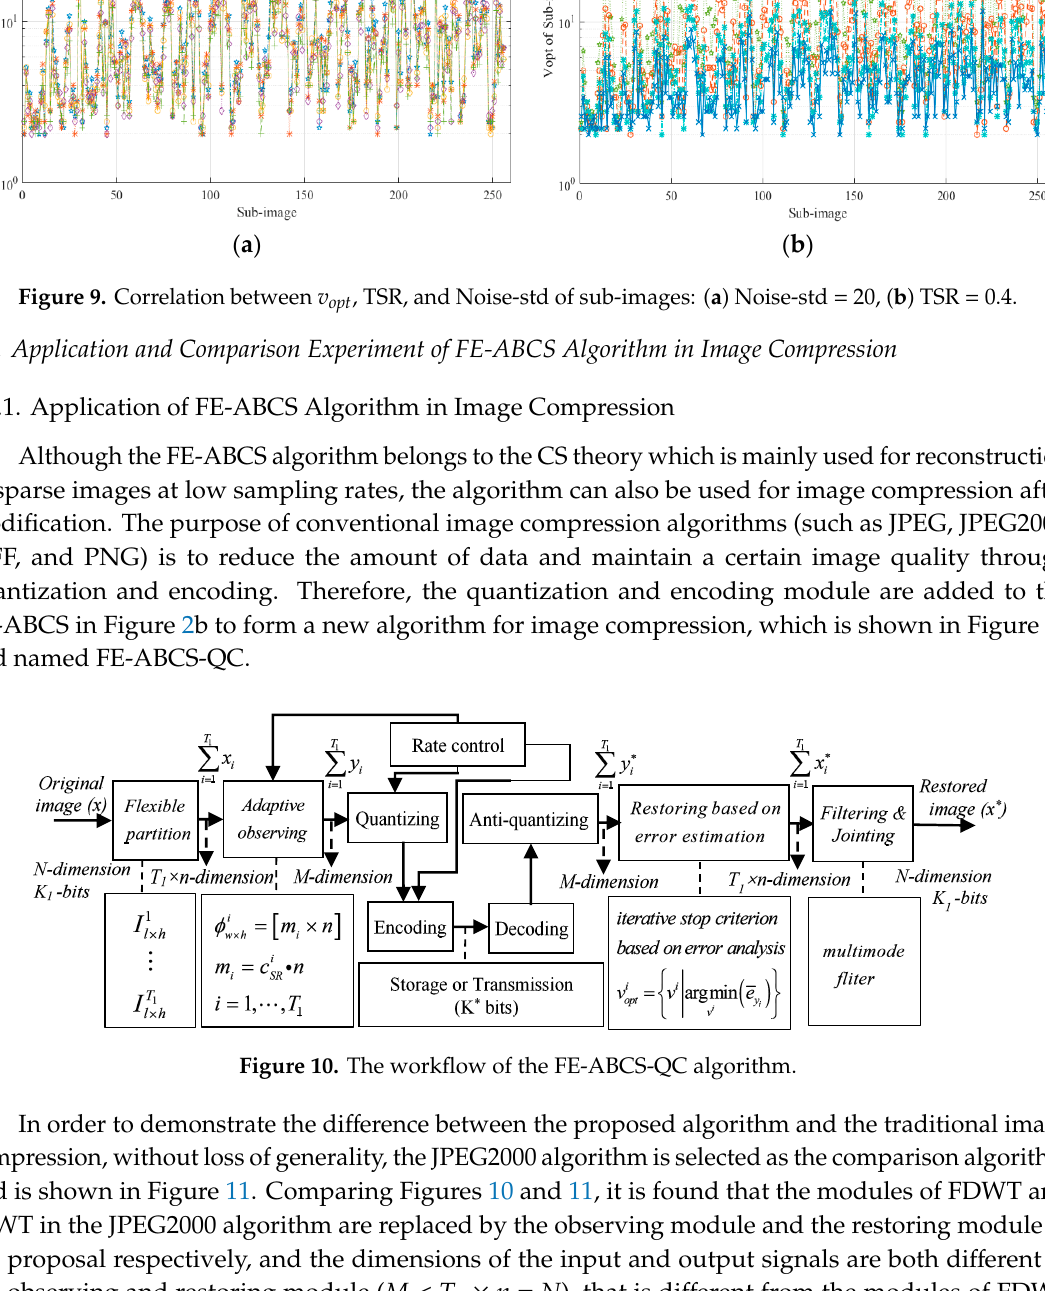
Figure 10. The workflow of the FE-ABCS-QC algorithm.